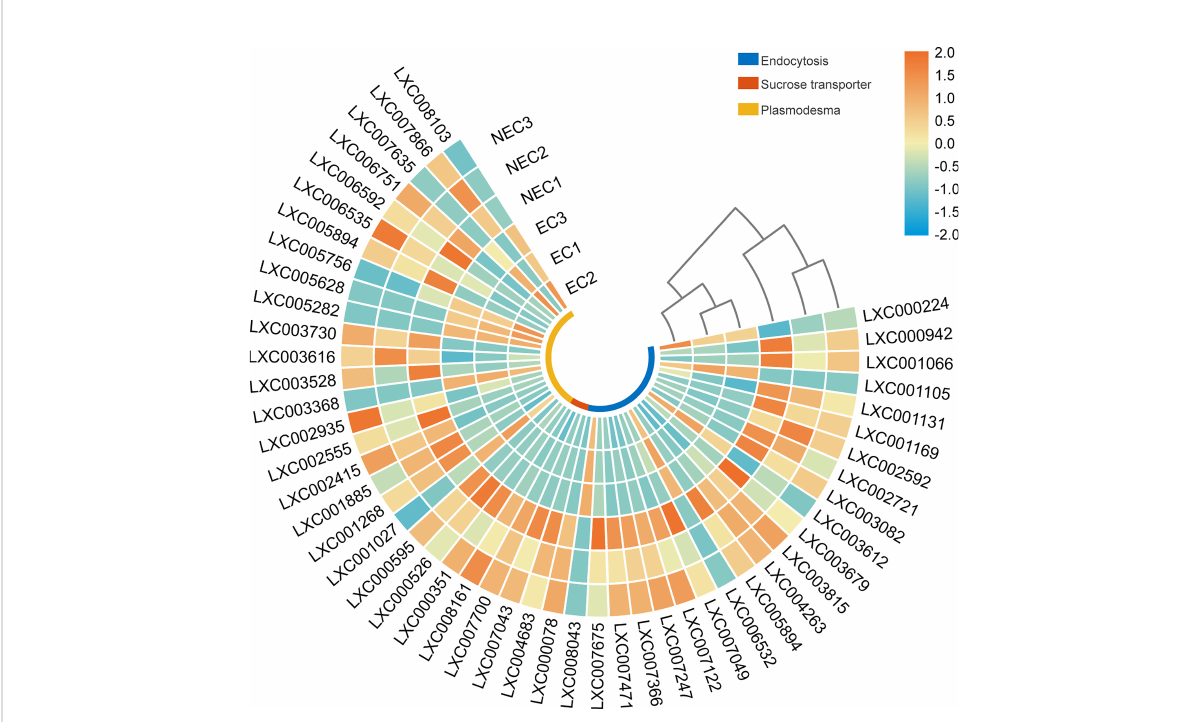
FIGURE 7 Heat map displaying the expression level of differentially expressed genes (DEGs) in photoassimilate transportation in EC and